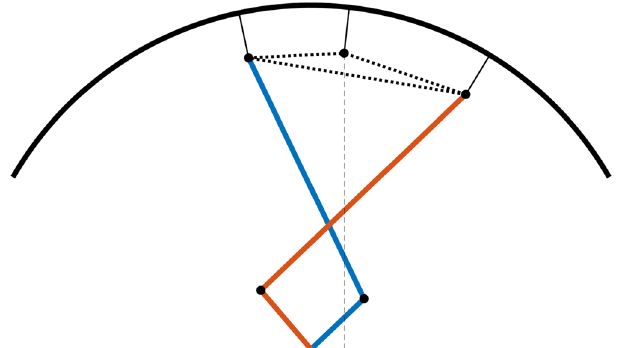
Figure 9. Visualization of the possible ideal form of the optimized set. This shape is impossible to manufacture due to the restrictions of the motor armature, however the input linkages can be concluded to be minimum to maximize performance of the 2-DOF wheel.